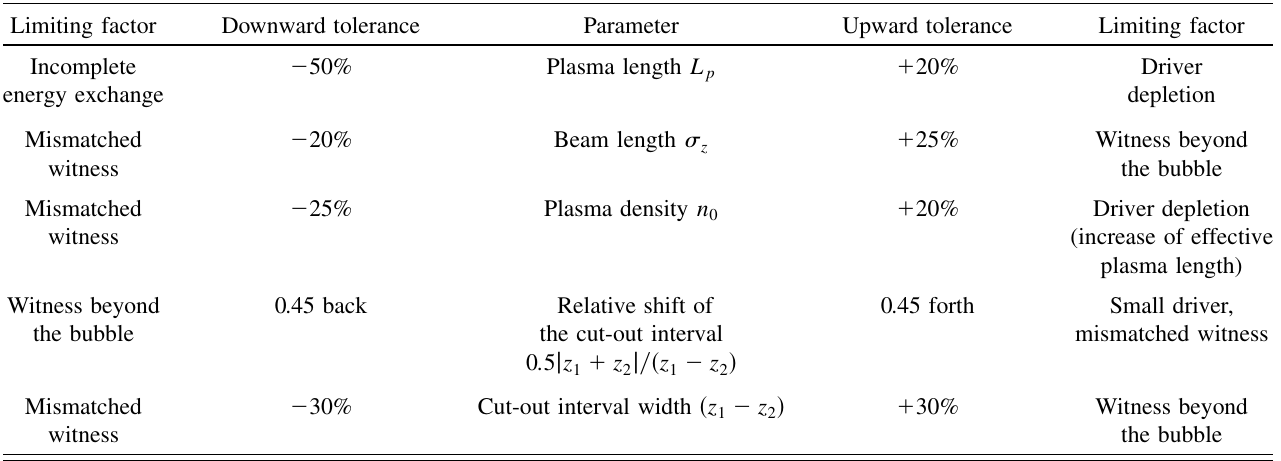
TABLE IV. Acceptable deviation of adjustable parameters from the optimum values.